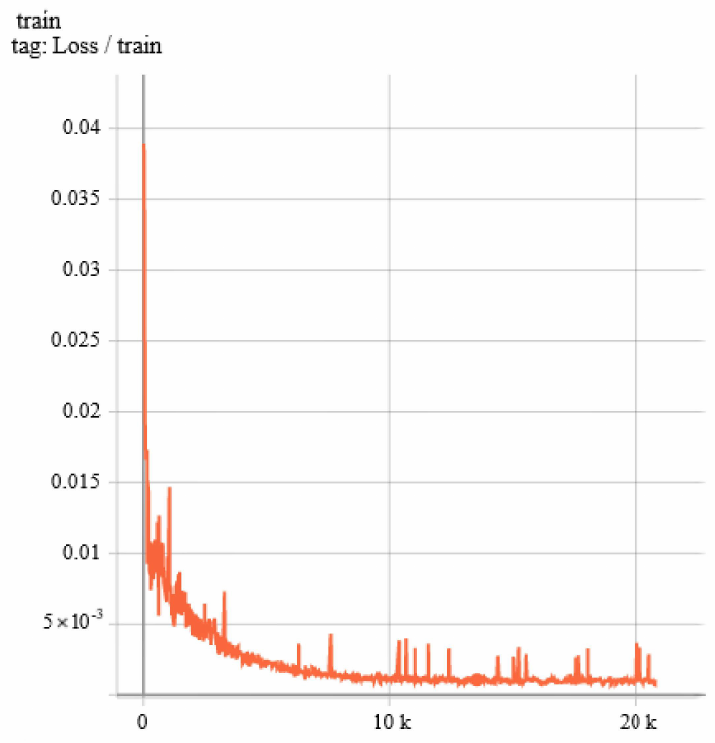
Figure 3. The training loss.